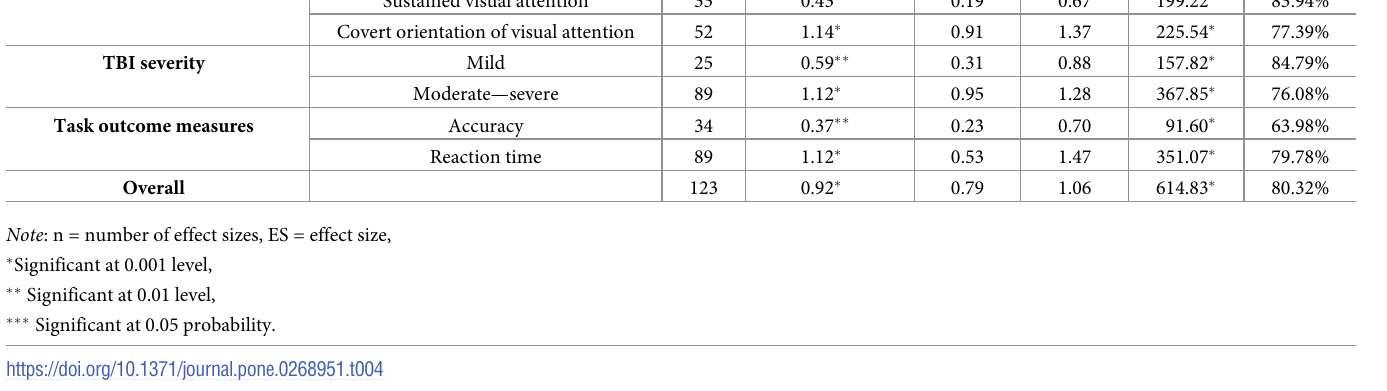
Table 4. Key results from the meta-analysis classified in terms of TBI severity, the component of visual attention and the type of outcome measure. n Combined ES 95%